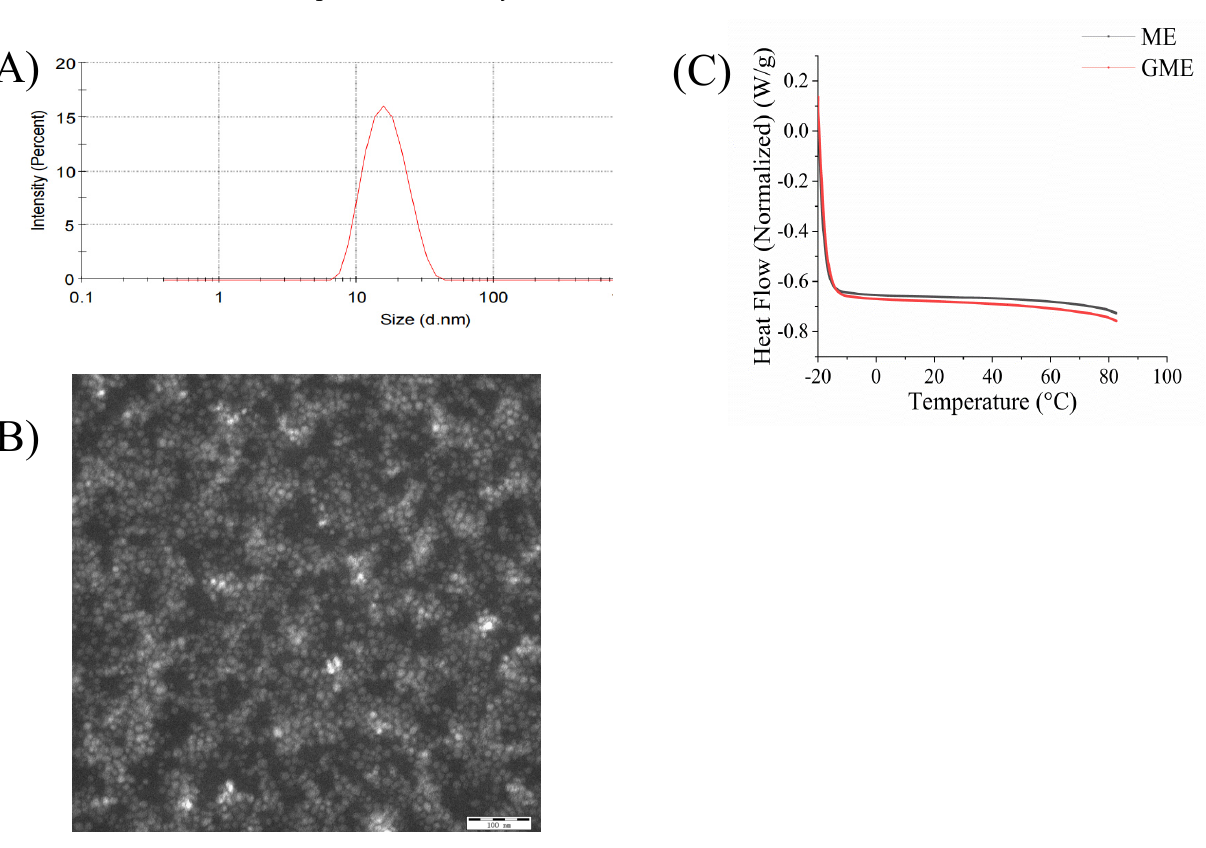
Figure 2. The particle size, morphology, and DSC melting thermograms of the GME. Particle size distribution ( A ); TEM ( B ); scale bar = 100 nm; DSC melting thermograms of GME and empty microemulsion ( C ).